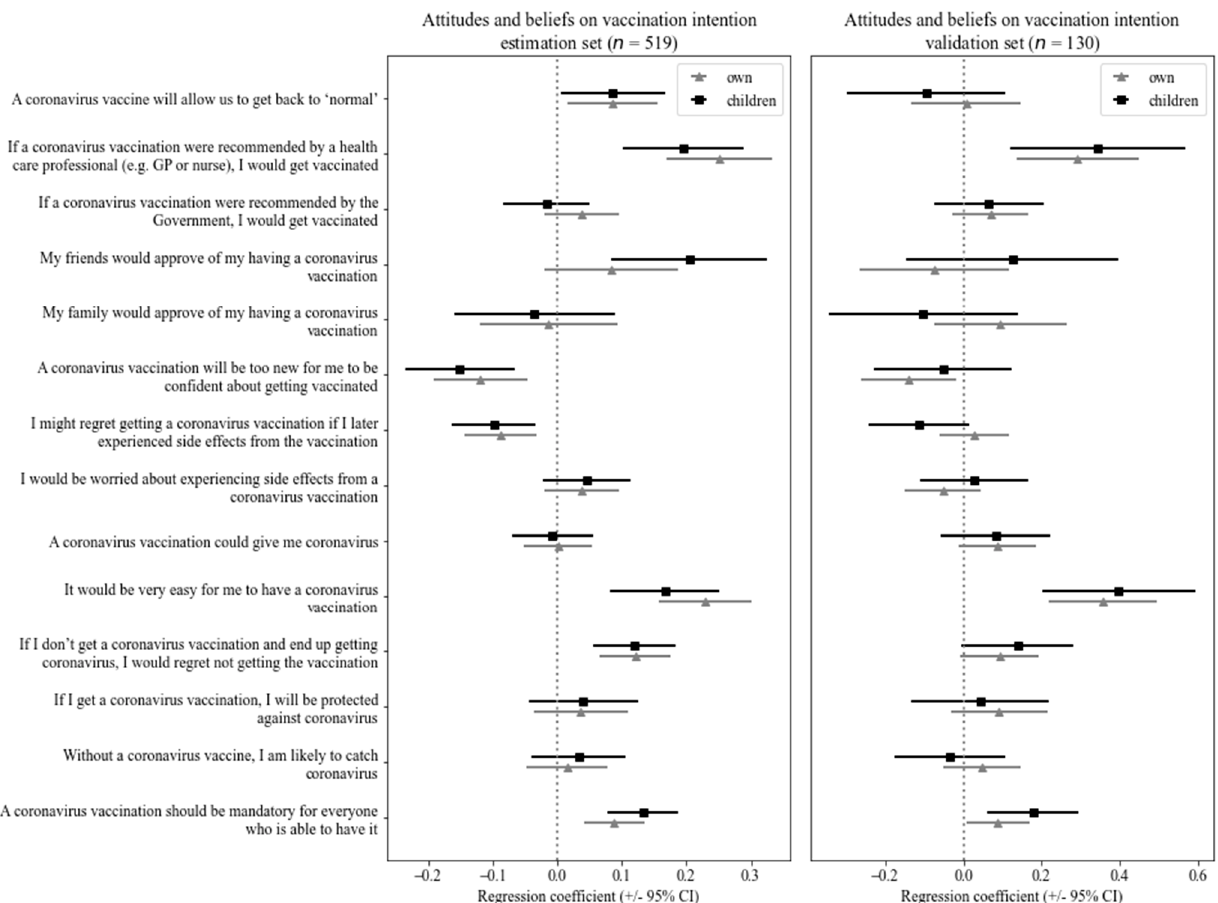
Figure 3. Results of multiple linear regression for predicting vaccination intention from general attitudes and beliefs towards the vaccine.